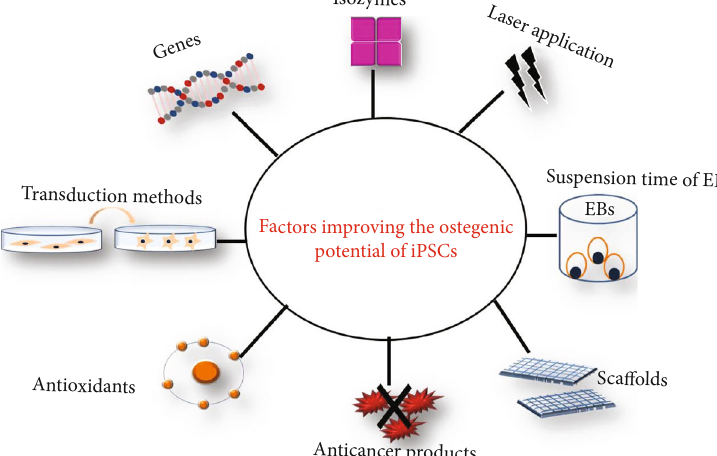
Figure 2: Diagram summarizing factors which may a ff ect osteogenic potential of